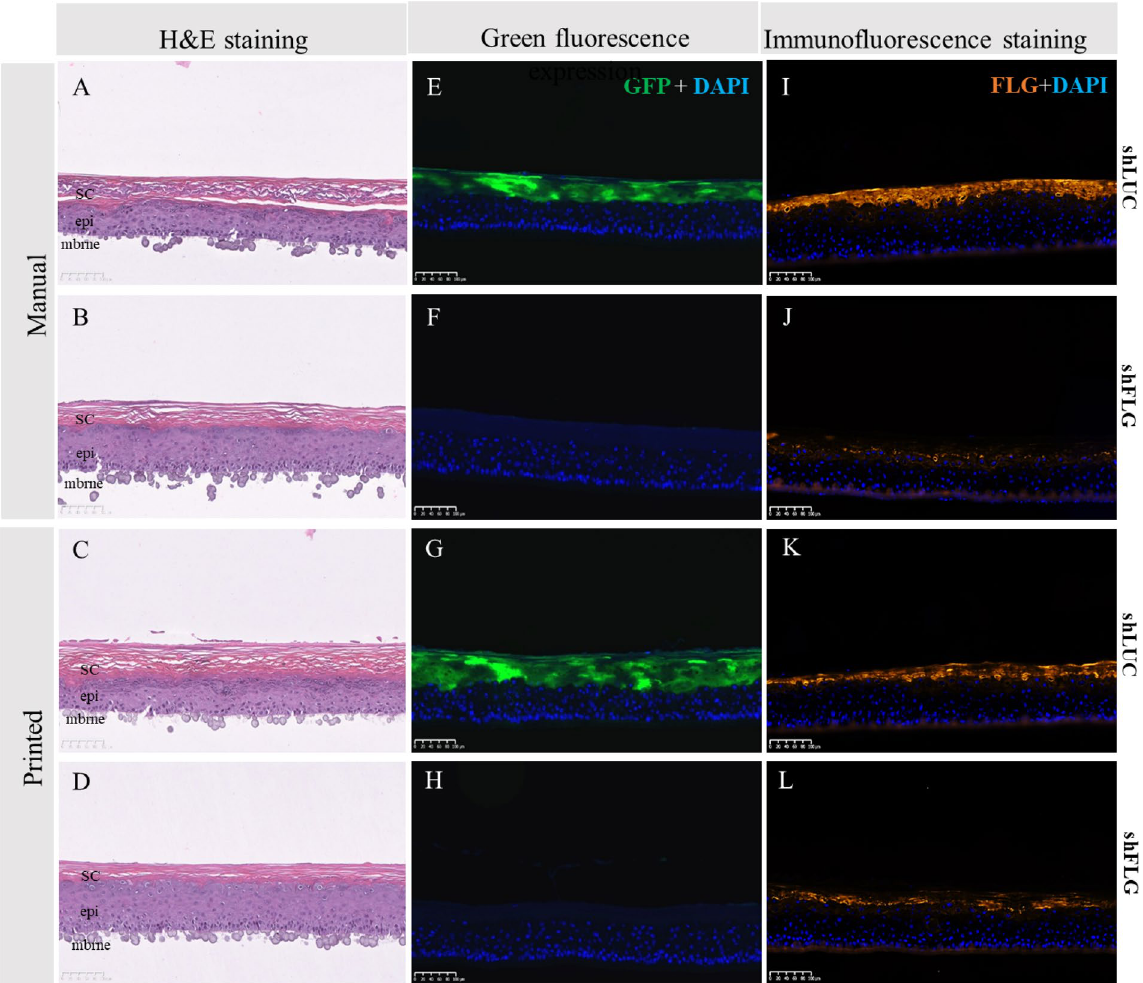
Figure 5. Histological examination of skin models reconstructed via manual seeding or bioprinting with shLUC or shFLG cells. ( A ) H&E sections of shLUC reconstructed samples manually seeded show a well- organized epidermal architecture, while ( B ) shFLG reconstructed samples demonstrate a pronounced hypogranulosis, consistent with FLG down-regulated skin. These data are consistent with those obtained via bioprinting ( C , D ). Manually seeded shLUC models expressed high levels of ( E ) GFP, which is not presented in shFLG samples ( F ). Manually seeded samples are indistinguishable from their bioprinted counterparts ( G , H ). Lastly, manually printed shLUC models highly express FLG ( I ), in contrast to samples reconstructed with shFLG NHK ( J ). There is no discernible difference in expression in models reconstructed using bioprinting ( K , J ). Images representative of 8 separate samples. SC stratum corneum, epi epidermis, mbrne polycarbonate membrane